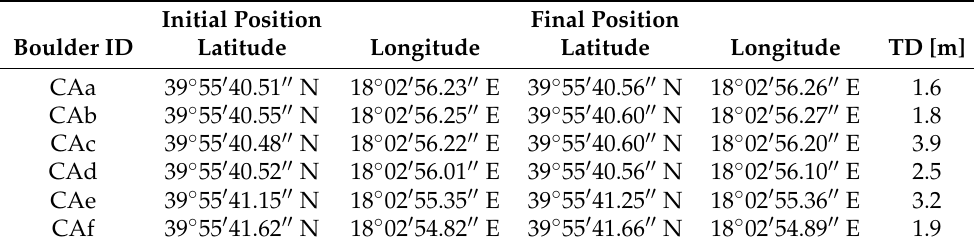
Table A11. Initial and final geographical coordinates of the displaced boulders at the Capilungo coast; ind.,